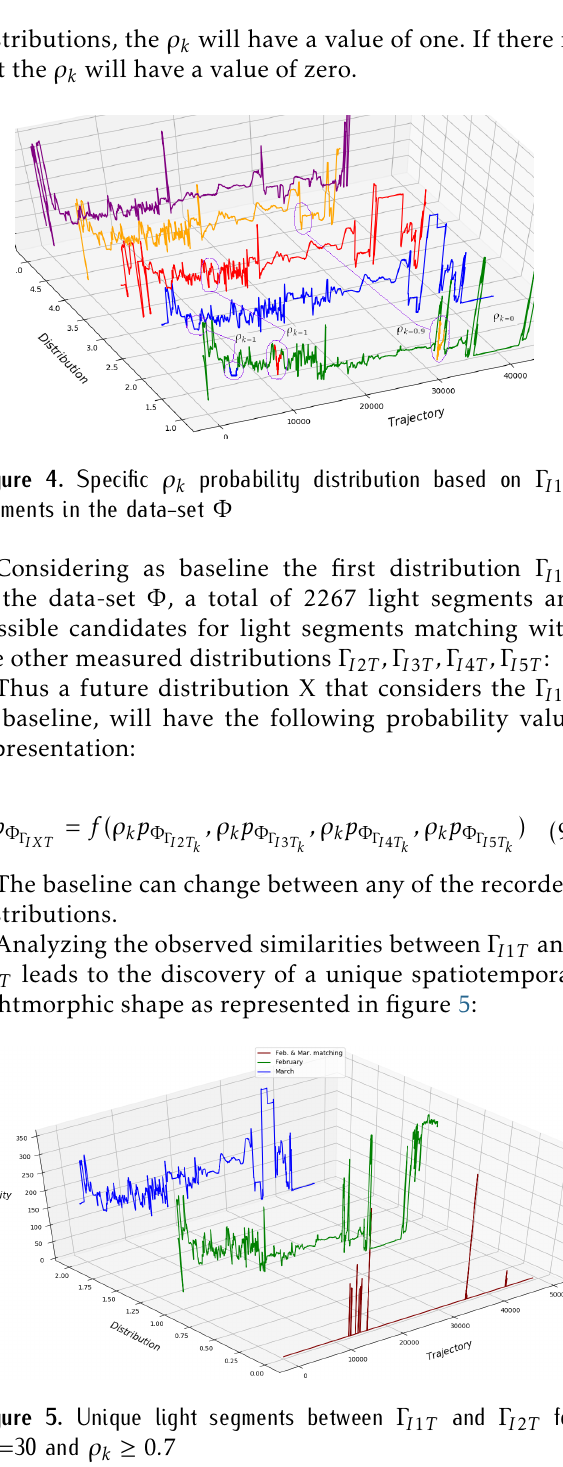
3. Non-unique matching light segments between